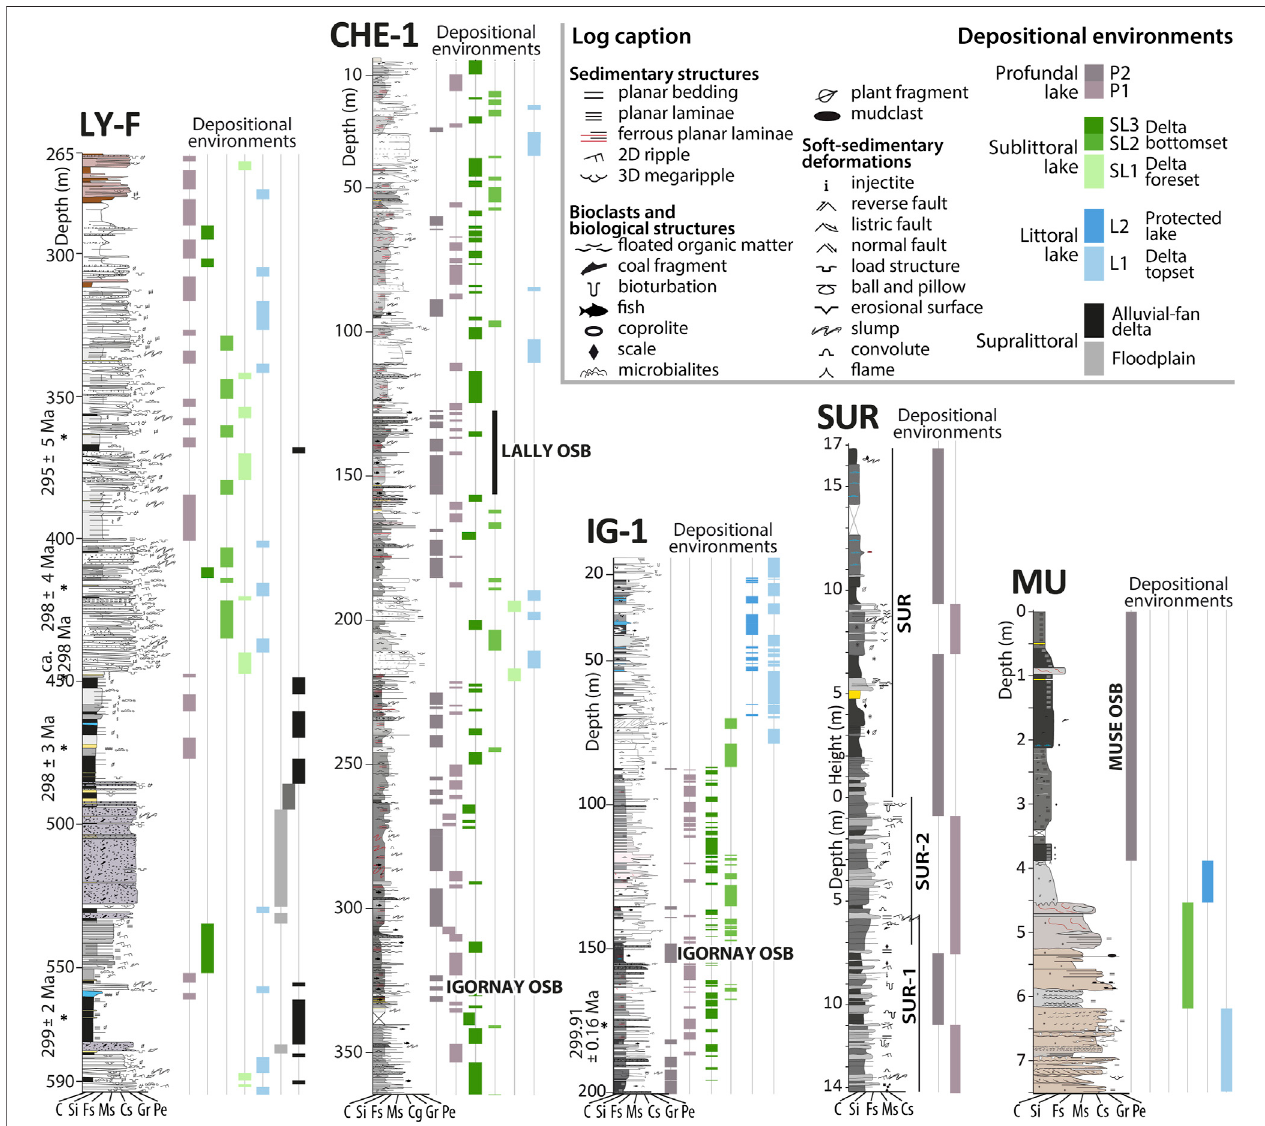
FIGURE 2 | Sedimentary logs of the successions of the Lucenay-lès-Aix area (LY-F core) and the Autun Basin (CHE-1, IG-1, and MU cores and SUR wells and section) as described in Mercuzot et al. (submitted), showing depositional environment evolutions through time (see Figure 1C for stratigraphical position of studied sections). C, clay; Si, silt; Fs, fi ne sand; Ms, medium sand; Cs, coarse sand; Gr, gravel; Pe,